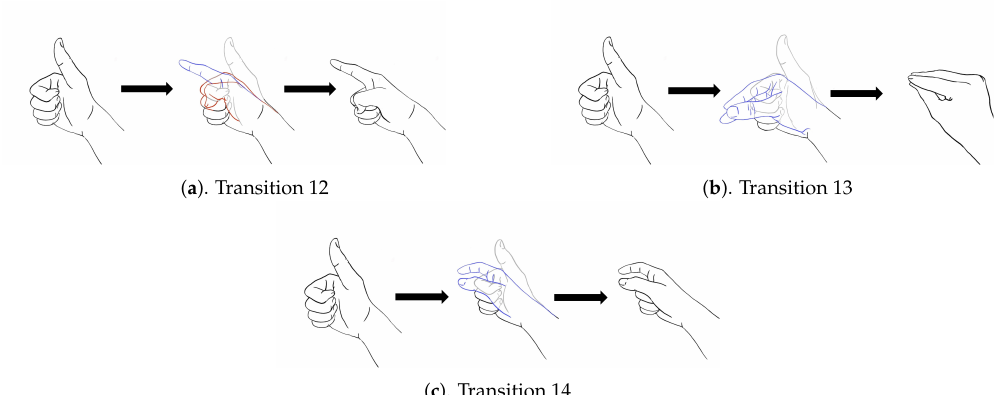
Figure 9. Three transitions associated with Gesture 1: Transition 12, Transition 13, and Transition 14, where Transition ij denotes transition from Gesture i to Gesture j